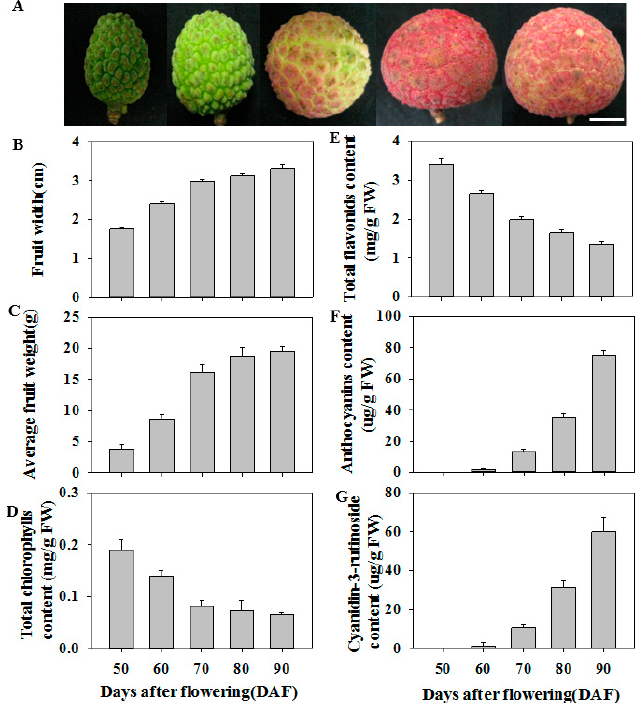
Figure 1. Visual appearance ( A ), fruit width ( B ), average fruit weight ( C ), total chlorophylls content ( D ), total flavonoids content ( E ), total anthocyanin content ( F ), cyanidin-3-rutinoside content ( G ) of litchi fruit during ripening. Left to right: fruit at 50 days after flowering (DAF), 60 DAF, 70 DAF, 80 DAF, and 90 DAF. Bar = 1 cm. Each value represents the mean + standard error (n = 20 in B and C; n = 3 in